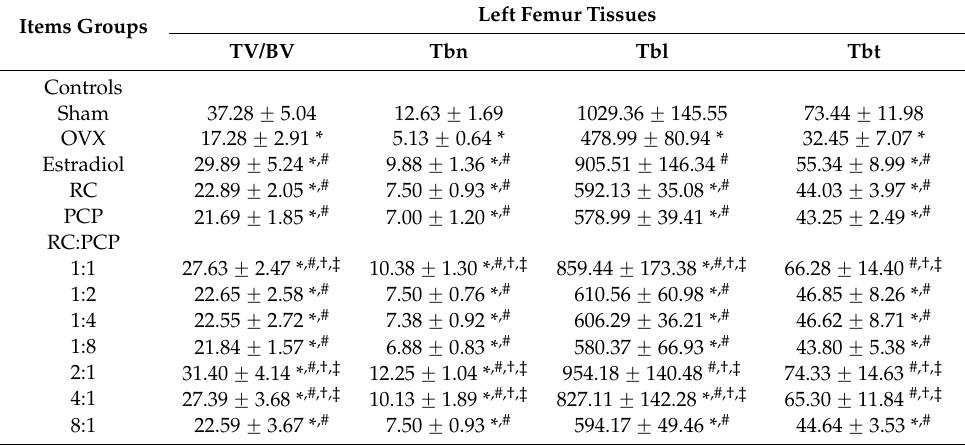
Table 7. Histopathology-Histomorphometry for the femur in sham-operated or OVX ddY mice: trabecular bones.